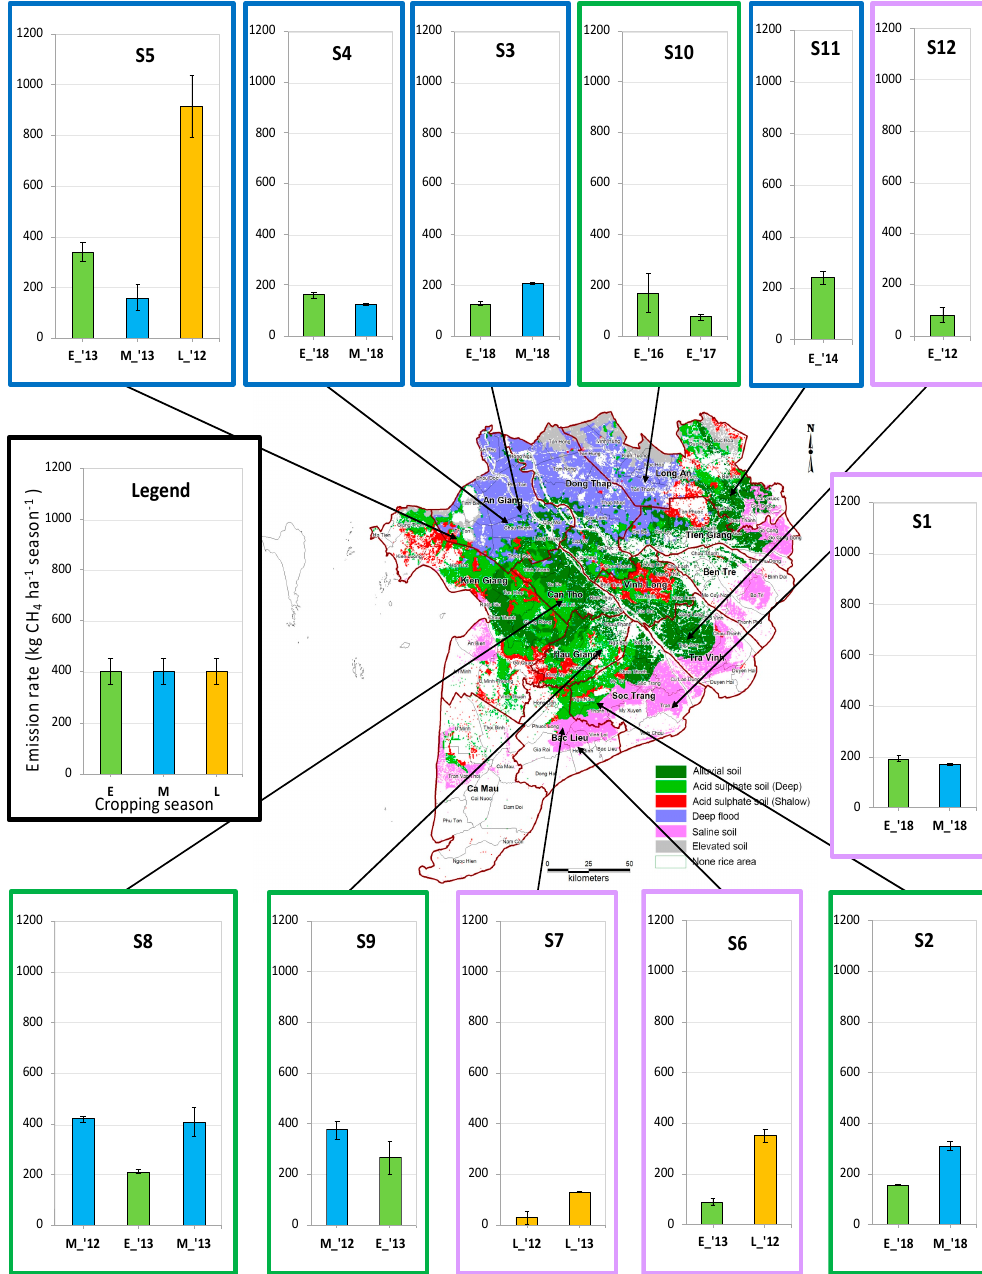
Figure 3. Seasonal emission rates in field experiments in South Vietnam with field sites marked in a map adopted from Wassmann et al. [20], colored frames indicate alluvial (green), deep flood (blue) and saline (magenta) zones; rice crops in the early year (E), mid-year (M) and late-year (L) seasons are named spring, autumn and winter paddy in General Statistics Office (GSO) statistics, respectively; standard errors among three replicates shown as error bars, crops are shown in sequential order which does not always correspond to the chronological order shown in Figure 2.